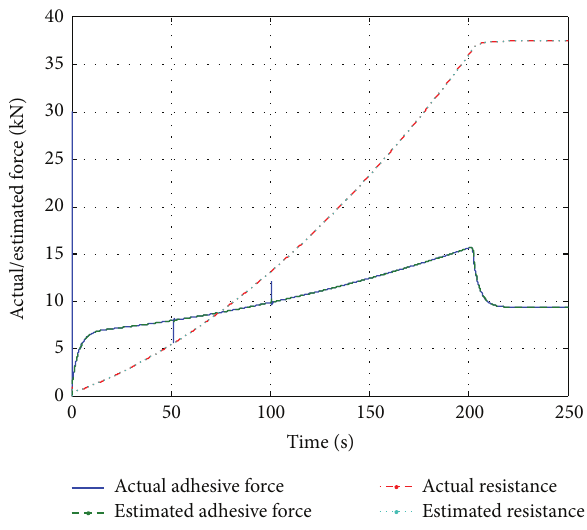
Figure 12: Observer